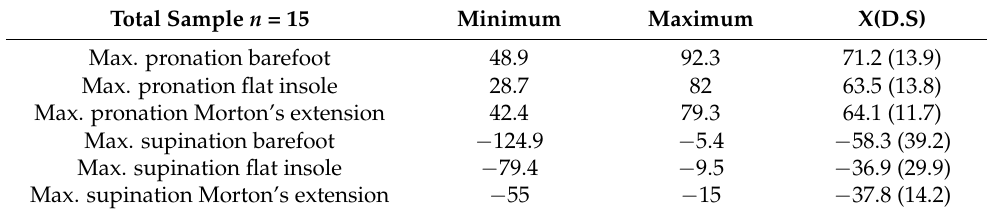
Table 1. Maximum pronation and supination force with respect to the footwear, the flat insole and the flat insole with a Morton’s extension insole situation is shown. The measures are shown in Newton for a 95% confidence interval; a normal distribution of the variables is presented. (Fx